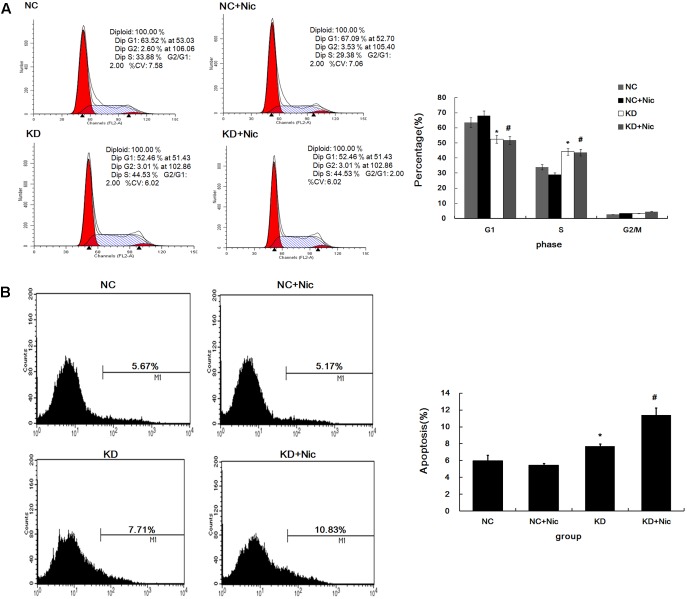
Cell cycle and apoptosis change following α5-nAChR silencing in A549 cells. (A) Cell cycle progression of various groups was monitored by fluorescence-activated cell sorting (FACS) analysis (Left) and quantitative analysis of cell cycle distribution is shown (Right). (B) A549 apoptosis in various groups was assessed by Annexin V-APC (Left) and quantitative analysis of apoptosis percentage is shown (Right). ∗P < 0.05 KD vs. NC; #P < 0.05 KD+Nic vs. NC+Nic.